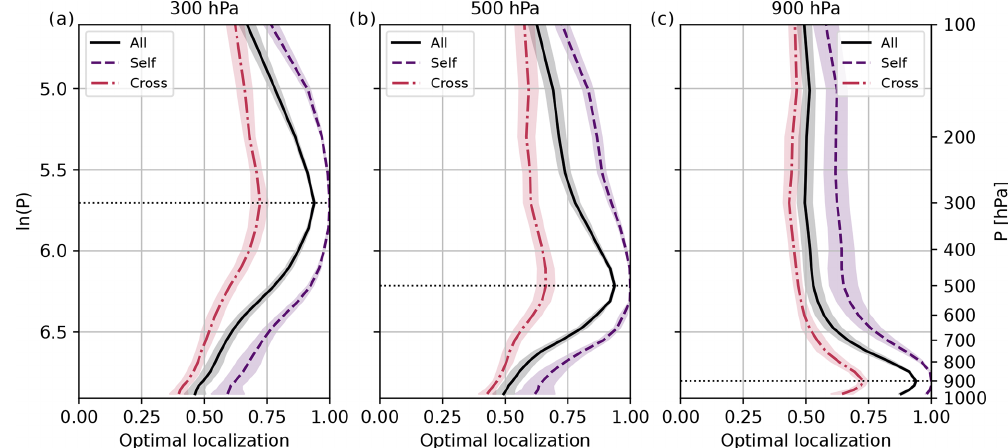
Figure 8. EOL for vertical sample correlations of 40-member ensembles and different variable combinations (self, cross, and all): reference